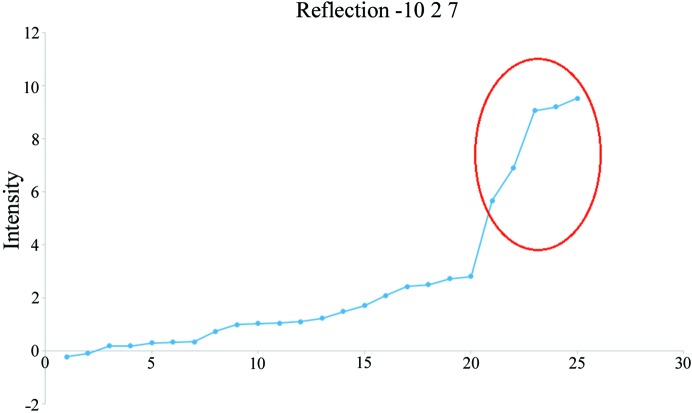
Reflections −10 2 7 in [PPh4][UCl6] sorted by intensity showing contamination by the umweganregung MD effect (five strongest measurements, outlined in red, rejected in this extreme case).